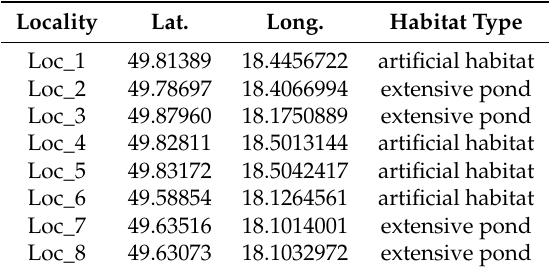
Table 2. Location of the study